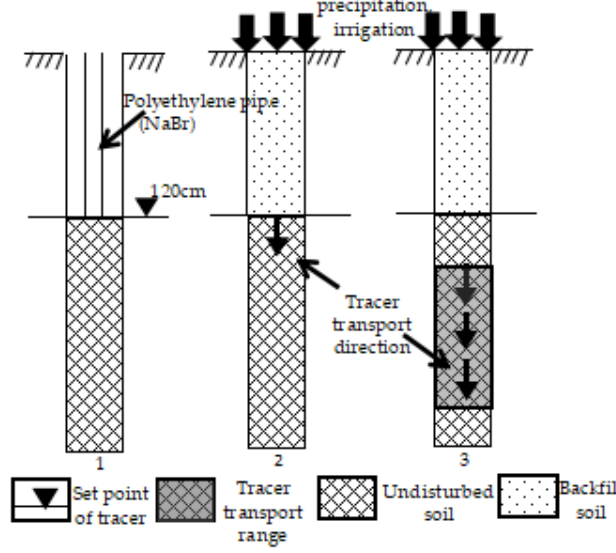
Figure 2. The principles diagram of the tracer experiment.